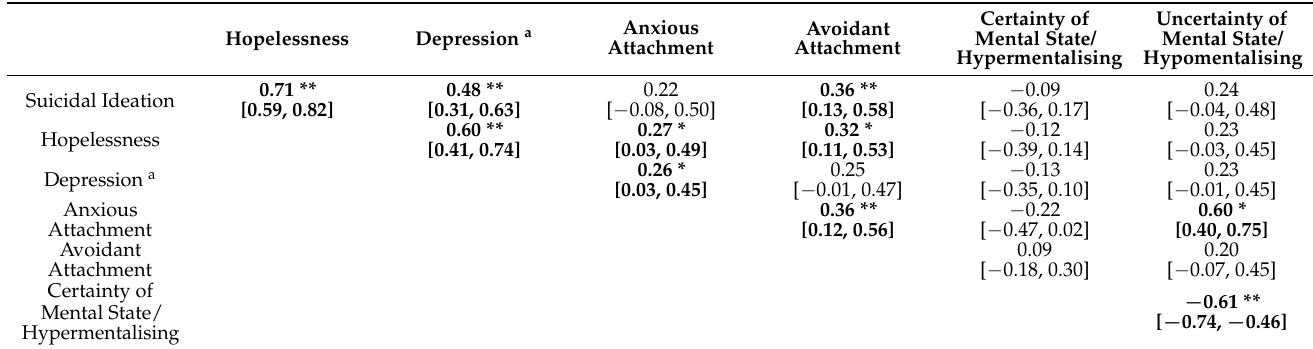
Table 3. Partial correlations, controlling for age and gender.